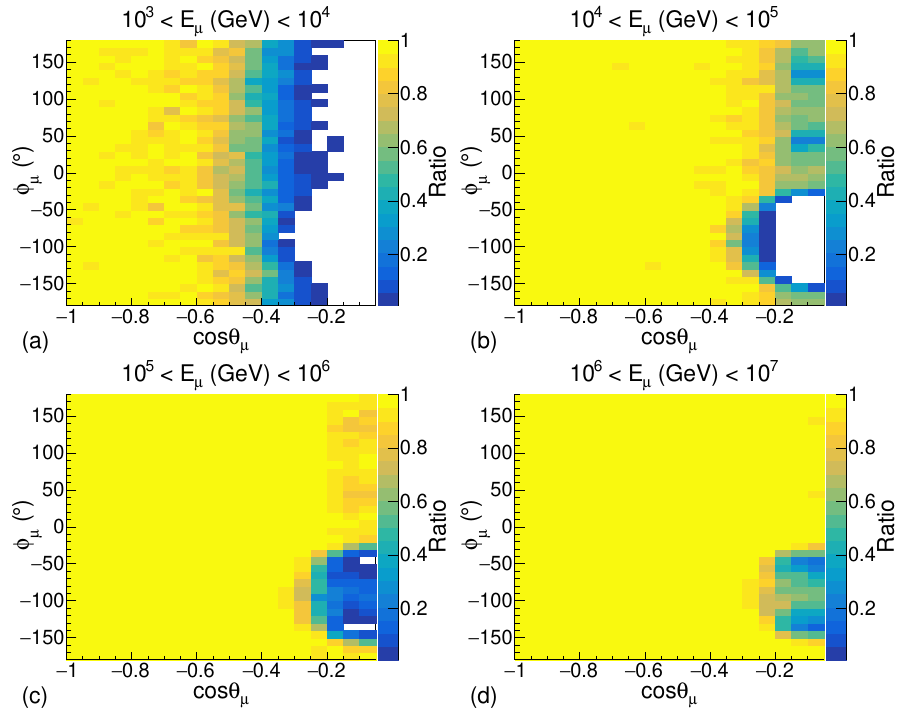
Figure 6. The ratio of the number of muons detected to the number of muons generated in the simulation with the shore with respect to the muon arrival direction for energy ranges: ( a ) 10 3 – 10 4 GeV, ( b ) 10 4 –10 5 GeV, ( c ) 10 5 –10 6 GeV, and ( d ) 10 6 –10 7